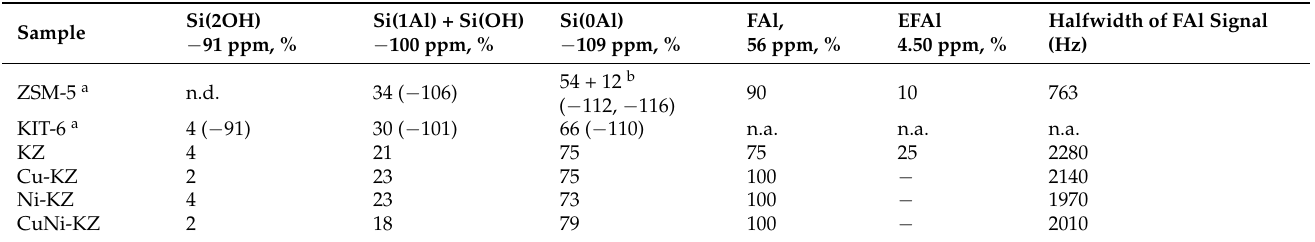
Table 2. Signal area of the different Si structural units, obtained via deconvolution of the spectral patterns in the single-pulse 29 Si spectra, and the relative fractions of FAl and EFAl species, determined from 27 Al